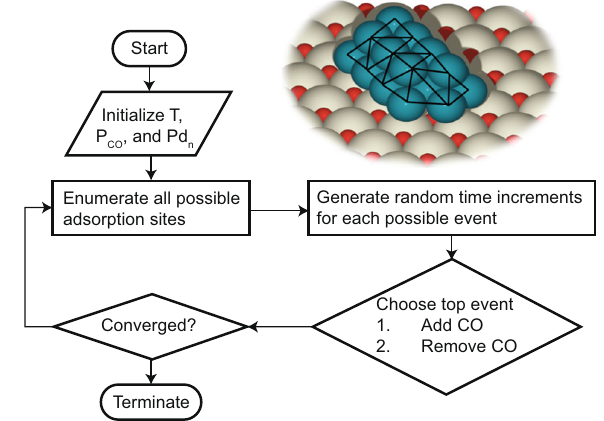
Fig. 9 | Generation of low-energy cluster/adsorbate ensemble. Schematic showing the steps of the rejection-free Grand Canonical Monte Carlo (GCMC) scheme, with an example of triangular mesh generated by Delaunay Triangulation to determine all surface atoms and possible adsorption sites on Pd 20 /CeO 2 . Ver- tices, edges, and centroids of the triangles correspond to atop, bridge, and hollow sites,